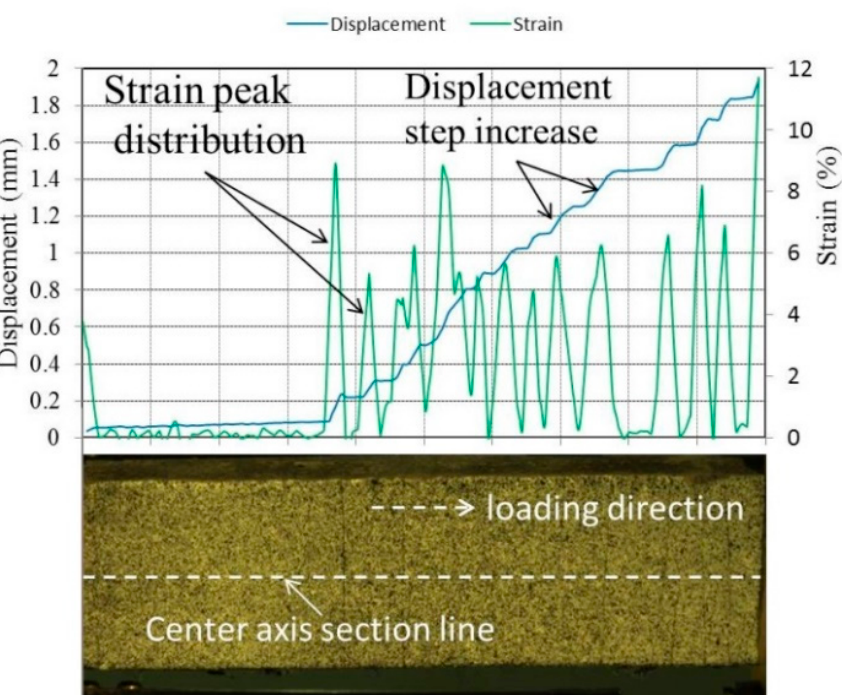
Figure 9. Displacement distribution and strain distribution of the central